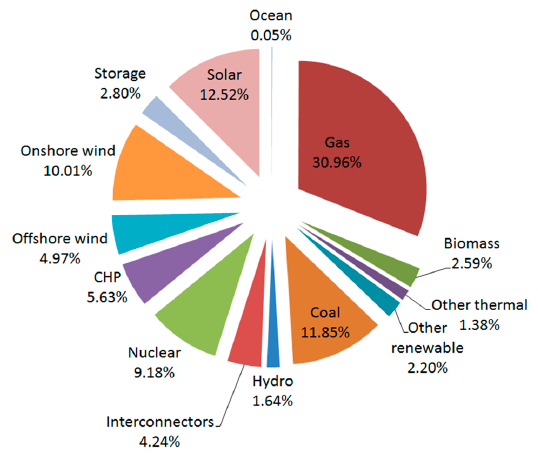
Figure 2. Contribution of different energy sources to the total capacity installed in the UK at the end of 2016 [19].